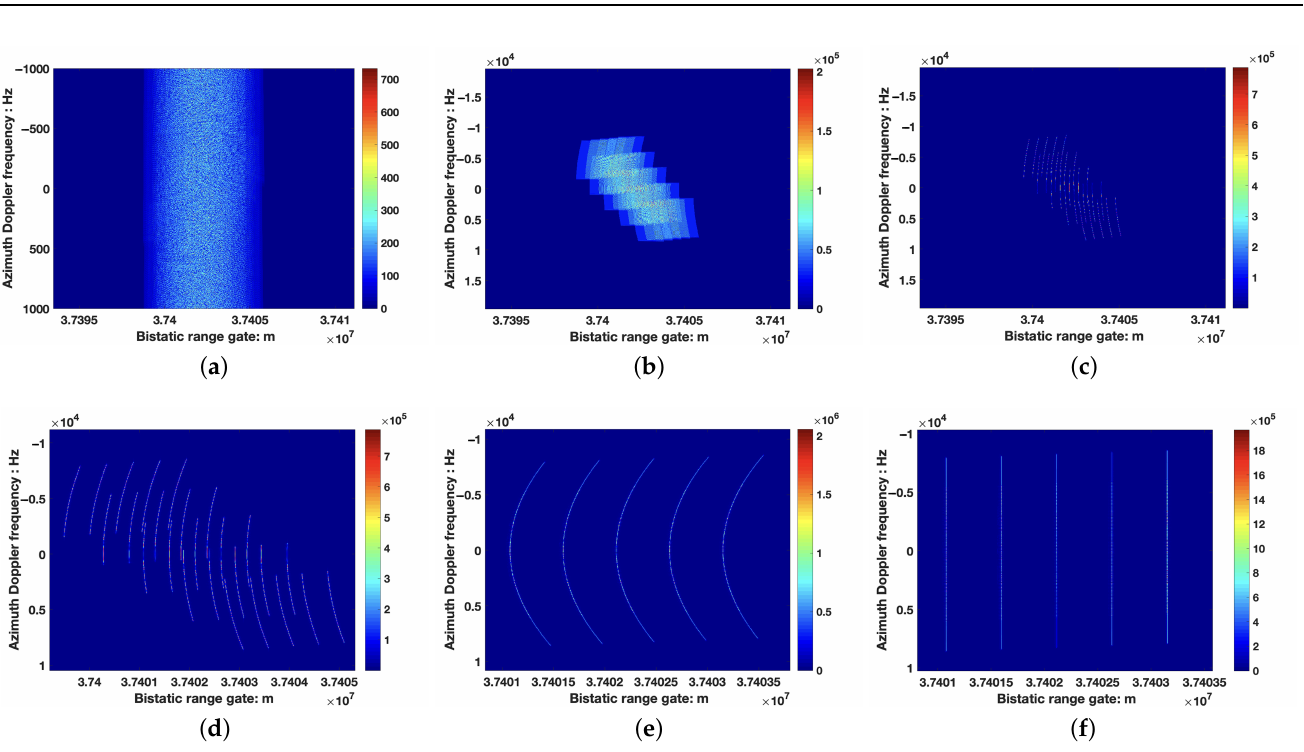
Figure 10. Simulation data processing. ( a ) The range-Doppler data is aliasing because the PRF is far less than the bandwidth of the received signal. ( b ) After the azimuth deramping pre-processing, the aliasing problem is removed and the efficient range-Doppler algorithm works. ( c ) The range compression is performed. ( d ) After the range compression, we zoom in the target area, the azimuth and range variance can be seen clearly. ( e ) Through azimuth variance analysis and correction, the targets with the same R r 0 are confined in the same range migration curve. ( f ) Through range variance analysis and correction, the bulk RCM correction is performed and the spectrum of the targets become straight